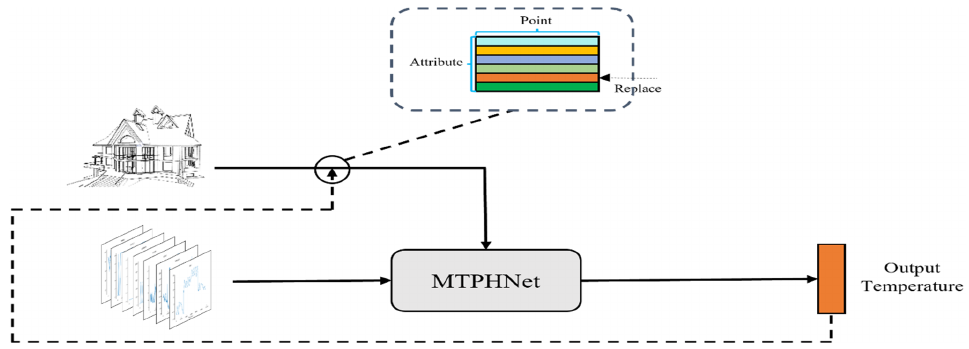
Figure 8. Temperature substitution process. The temperature value calculated by the model replaces a certain dimension of the input to simulate the temperature change of all objects in the temperature field at each moment.